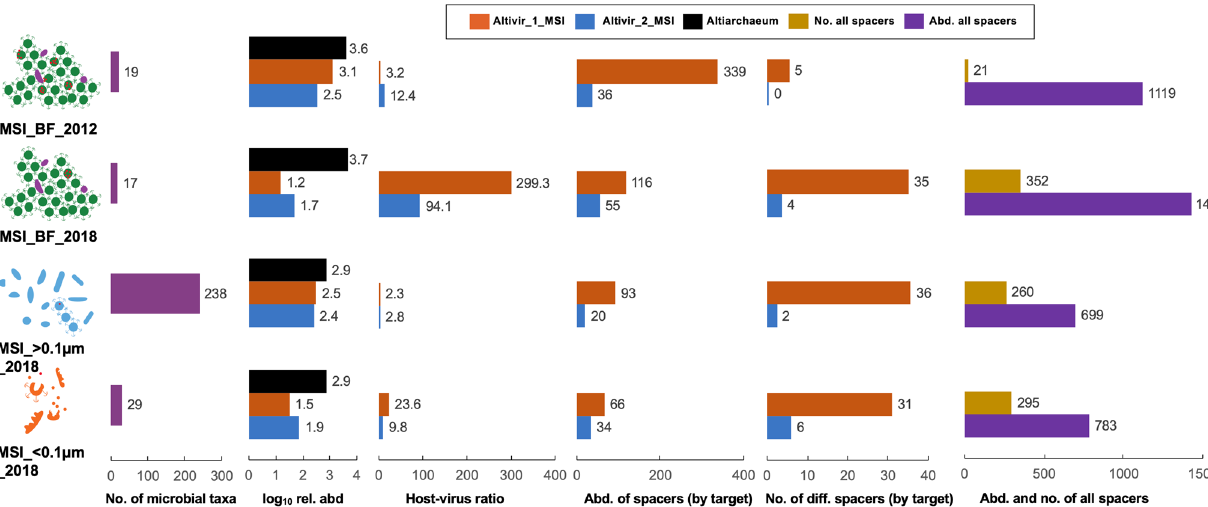
Fig. 4 Development of host – virus and spacer dynamics from 2012 to 2018 based on metagenomics from the Mühlbacher Schwefelquelle, Isling (MSI). Predicted viruses Altivir_1_MSI and Altivir_2_MSI became less abundant from 2012 to 2018. Data are presented for bio fi lms (BF) from 2012 and 2018 as well as the planktonic fraction (>0.1 µ m) and the viral fraction (<0.1 µ m). Considering the BFs, total spacer abundance and numbers increased from 2012 to 2018 while those matching Altivir_1_MSI decreased in abundance but increased in numbers. Number (no.) of microbial taxa refers to the number of different prokaryotes in a sample detected via rpS3 rank abundance curves (normalized by sequencing depth). Host – virus ratio is calculated from host and virus coverage based on read mapping. Abundance and number of different spacers were normalized to minimum relative abundance (rel. abd.) of the host based on read mapping. Color de fi nition of bars: violet = number of microbial taxa, orange-red = features of Altivir_1_MSI, blue = features of Altivir_2_MSI, black = log 10 relative abundance of Altiarchaeum, ocher = number of all spacers, and purple = abundance of all